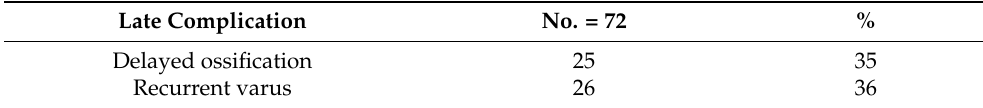
Table 1. Total number of cases of delayed ossification and recurrent varus in primary SH for type 1b 2 CFD. (CFD-Congenital Femoral Deficiency, SH-SUPERhip).